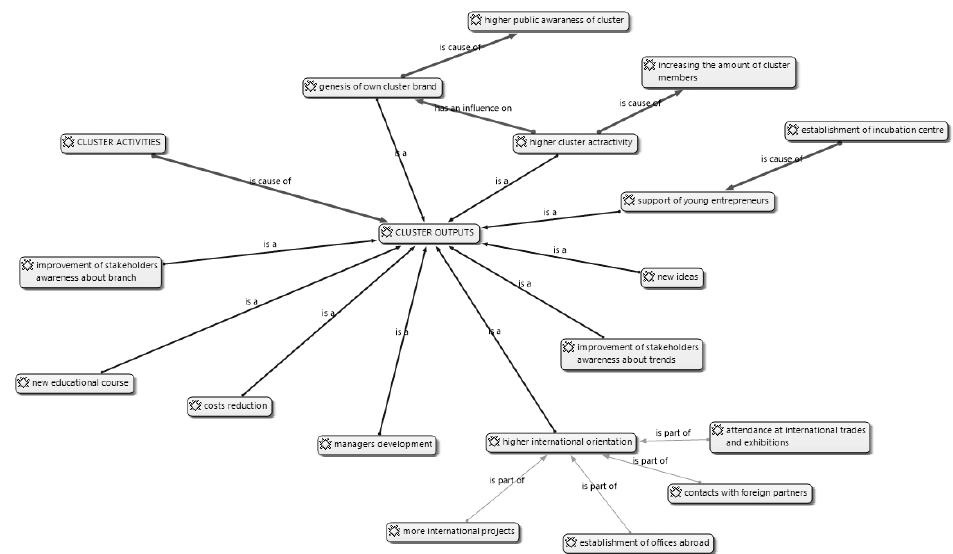
Fig. 3. Cluster outputs (source: created by authors, based on own research in Atlas.ti